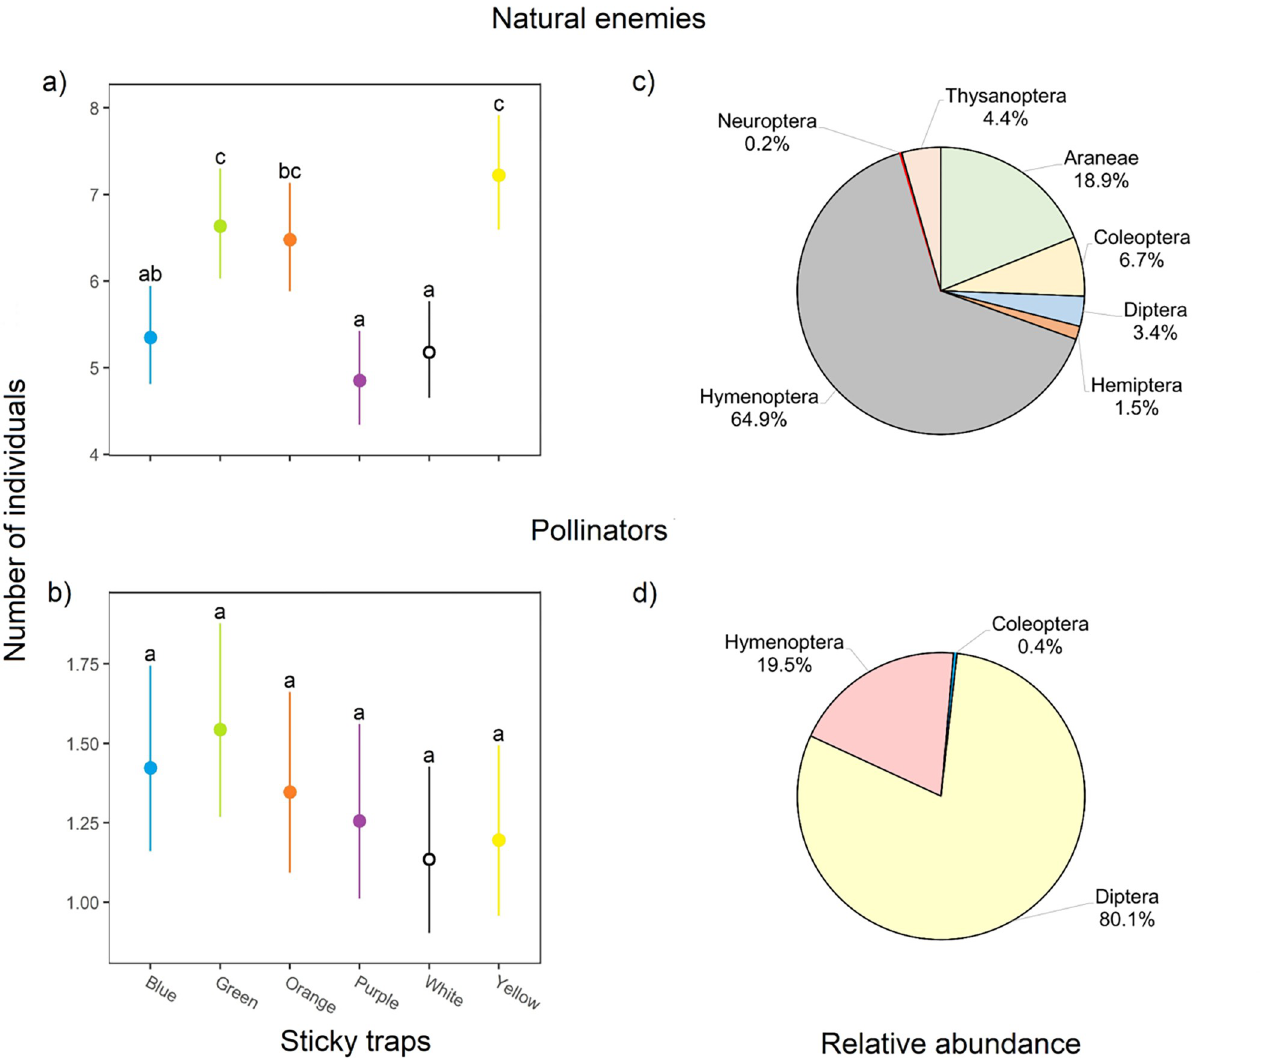
Fig 5. Attraction of beneficial insects to colored sticky traps during the Ataulfo mango flowering. Each point shows the mean catches of eight replicates in eight sampling dates, and the estimate marginal mean and error bars at 95% CI for natural enemies (a) and pollinators (b). Different letters indicate Tukey significant differences (p < 0.05). Relative abundances (%) of insect orders (plus Aranea) for natural enemies (c) and pollinators (d) are presented on the right